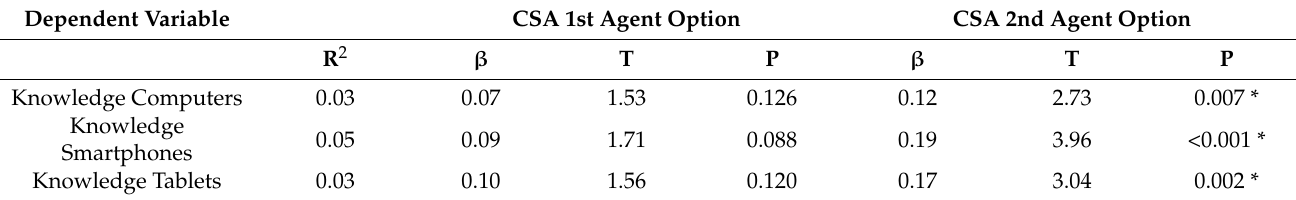
Table 3. Linear regression: ICT knowledge and CSA from first and second